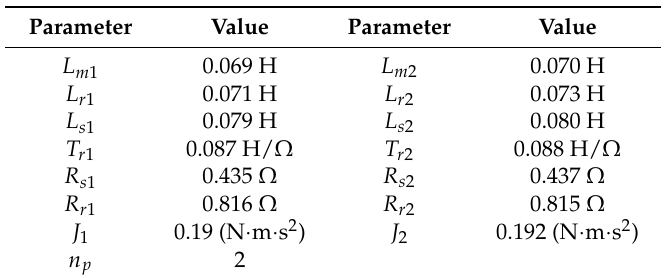
Table 1. Motors parameters